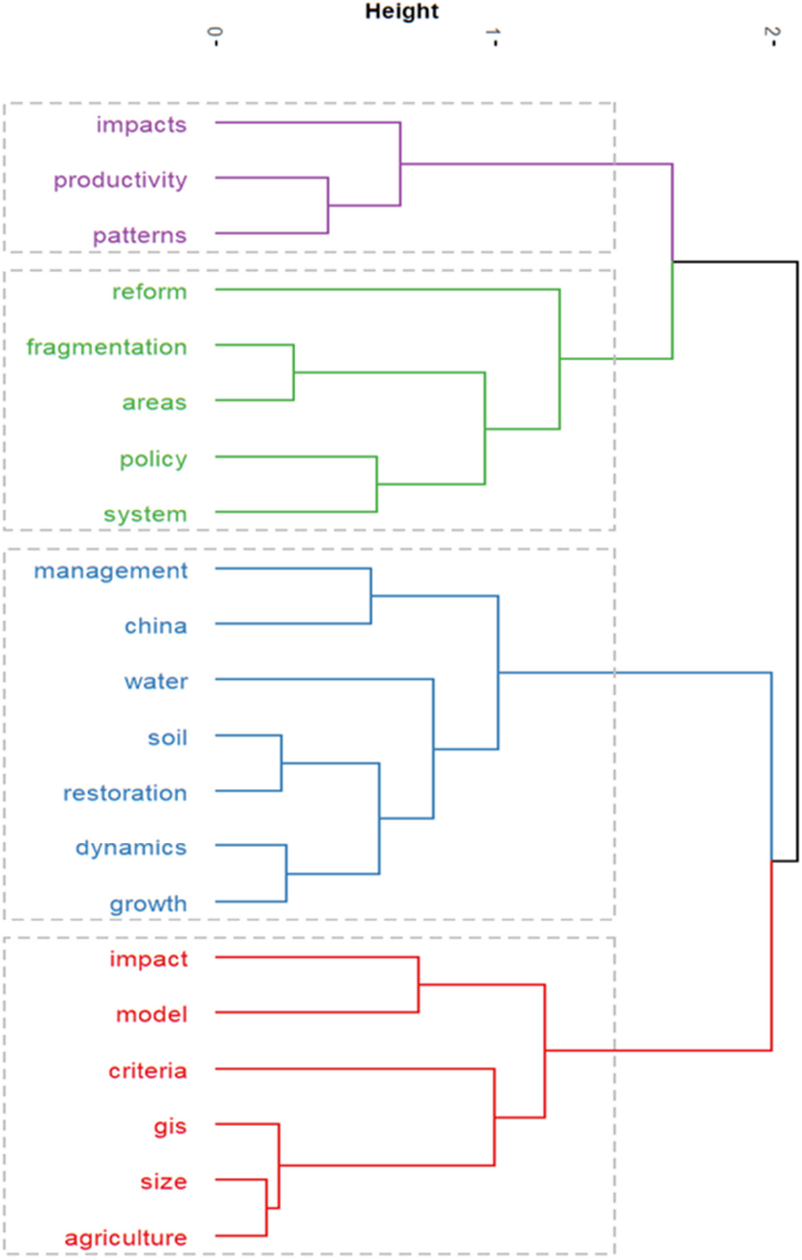
Figure 11. Tree dendrogram of hierarchical cluster analysis of keywords in the field of land con- solidation.